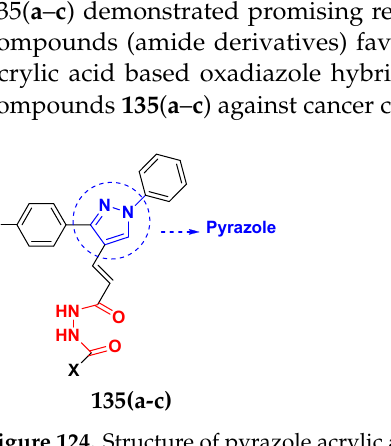
Figure 124. Structure of pyrazole acrylic acid-based oxadiazole derivatives 135 ( a – c ). Table 111. In vitro cytotoxic activities of pyrazole acrylic acid-based oxadiazole hybrid compounds 135 ( a – c ).